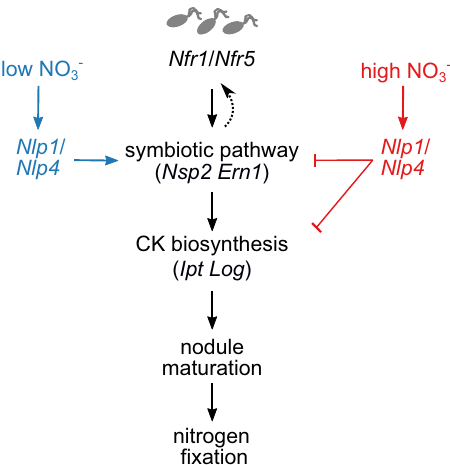
Fig. 9 Proposed model for regulation of nodule organogenesis by nitrate. In low nitrate, NLP signalling contributes to regulation of symbiotic genes, which stimulate cytokinin biosynthesis, ensuring robust nodule maturation and onset of nitrogen fi xation. In high nitrate, NLP-dependent nitrate signalling inhibits expression of symbiotic genes and symbiotic cytokinin biosynthesis that is crucial for nodule organogenesis. Nodulation is thus balanced between a permissive low-nitrate state where high cytokinin levels can accumulate, or a restrictive state with low root